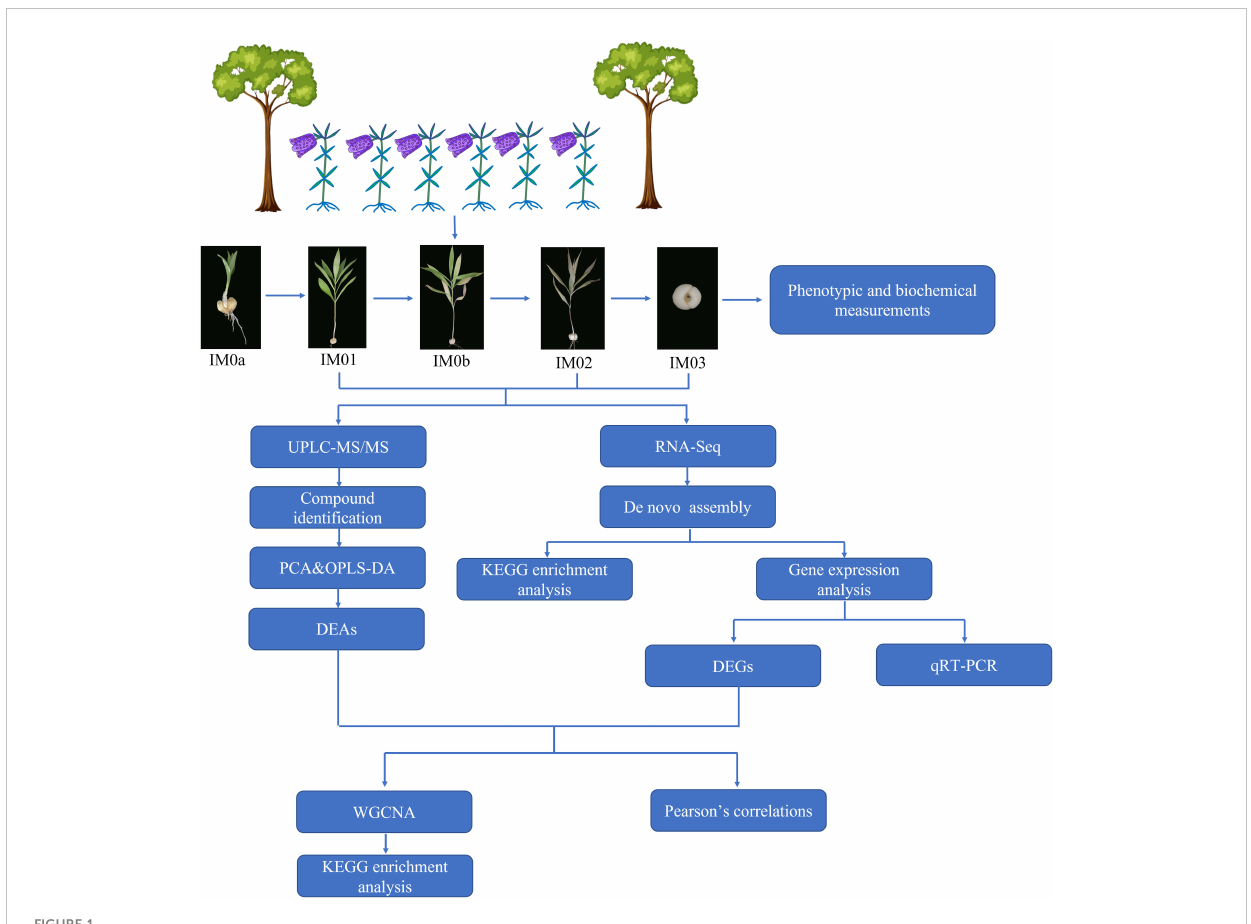
FIGURE 1 Schematic diagram of the analysis pipeline in this